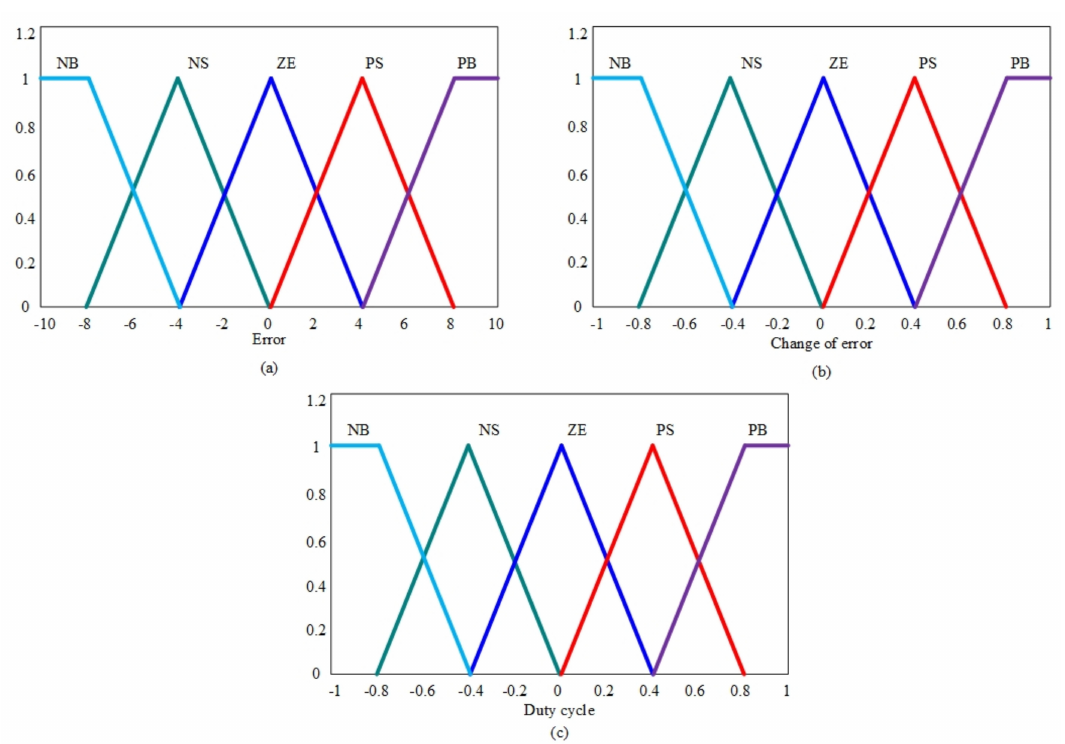
Figure 4. Membership function of ( a ) Error E ( b ) Change of Error CE ( c ) Duty ratio D